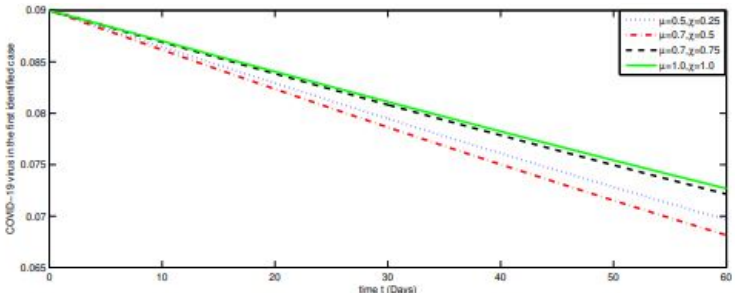
Figure 14. Graphs of numerical solutions at different fractal-fractional order for class M .